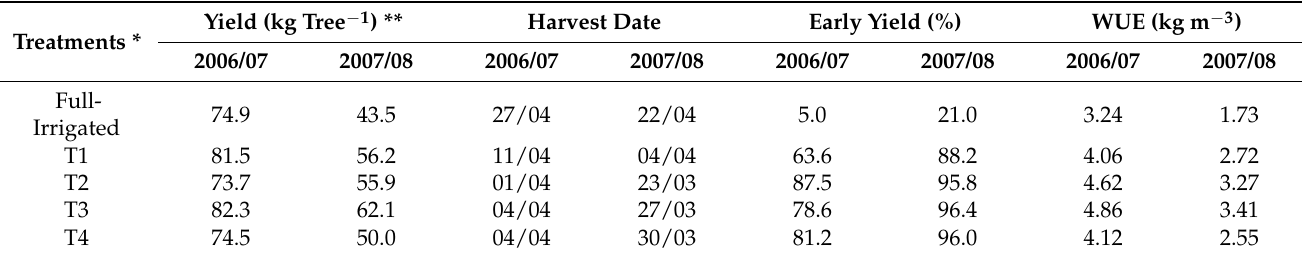
Table 3. Effects of deficit irrigation treatments on fruit earliness (mean harvest date and percentage of early yield obtained before 15 April), total yield and Water Use Efficiency